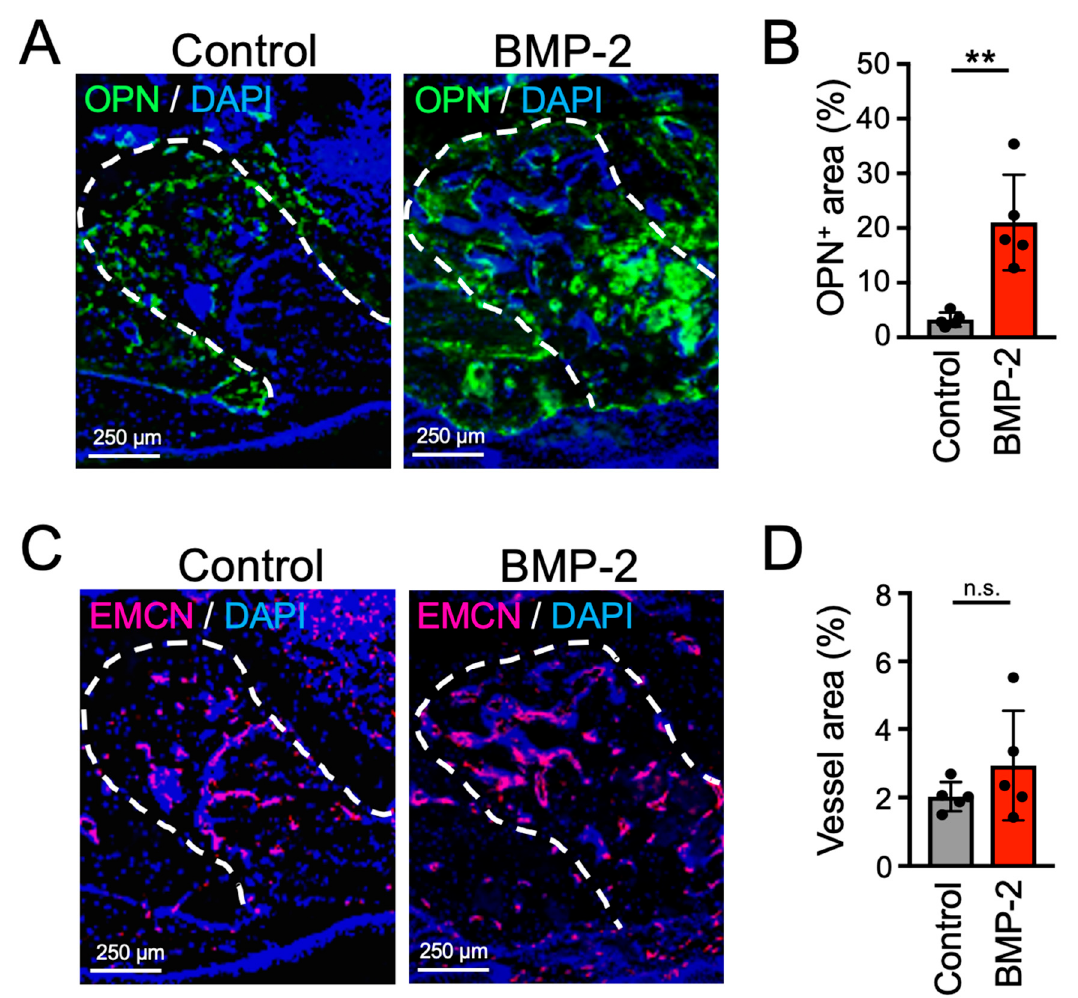
Figure 4. Immunohistochemical staining of OPN and EMCN in the tooth extraction socket in an MRONJ-like treatment model. ( A ) Immunohistochemical IHC staining images for OPN (green) and ( C ) EMCN (red) are shown, 4 weeks after transplantation. OPN: Osteopontin, EMCN: Endomucin. ( B ) The percentages of OPN positive area and ( D ) EMCN positive vessel area in the tooth extraction socket are shown in graphs. Bars represent the mean values and standard deviation (+/ − SD) ( n = 5). (** p < 0.01, ns: no significant difference, Student’s t -test). White dashed lines indicate the tooth extraction socket.